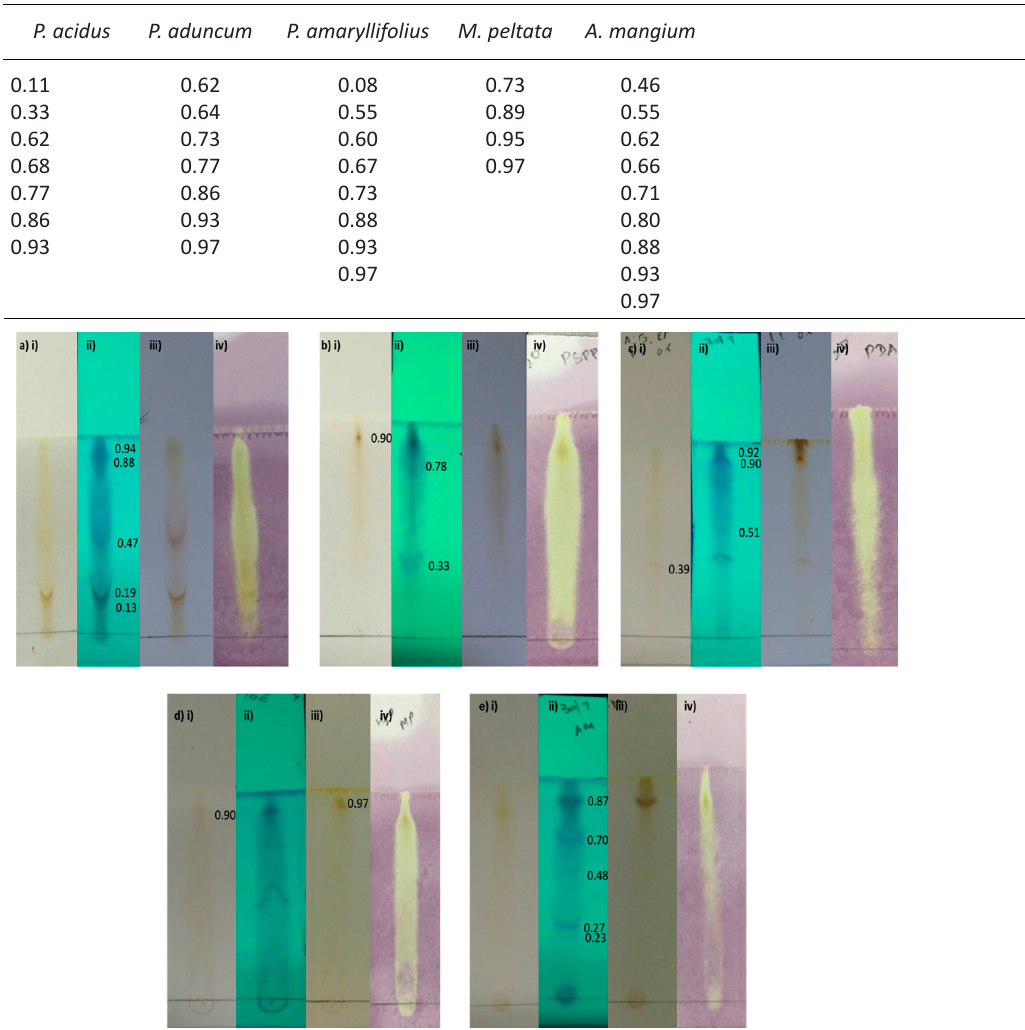
Fig. 2. TLC and TLC DPPH Bio-autography results of aqueous extracts of a) Phyllanthus acidus , b) Piper aduncum, c) Pandanus amaryllifolius, d) Macaranga peltata, e) Acacia mangium. i) Visible light ii) UV iii) Iodine vapour and iv) DPPH